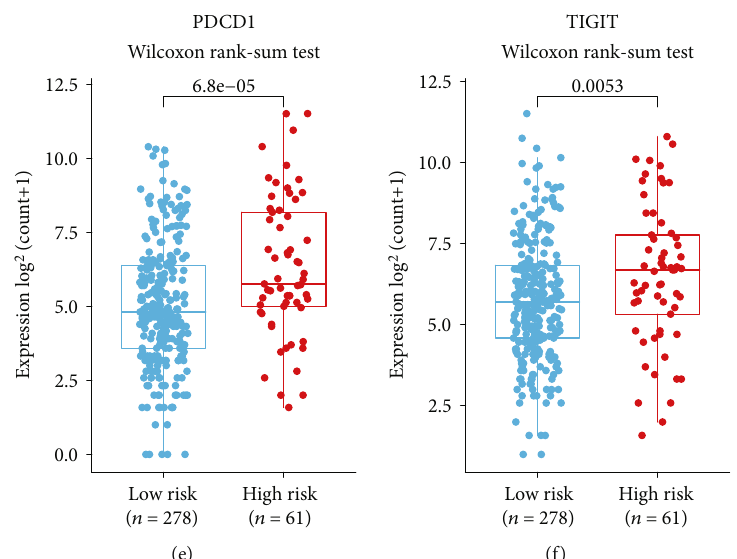
Figure 11: Immunotherapy response analysis. (a) Correlations between immune-related pathways and RS; Kruskal-Wallis test, ∗∗∗ P < 0 : 001 . (b – f) Correlations between several prominent immune checkpoints and RS: CTLA4 (b), HAVCR2 (c), LAG3 (d), PDCD1 (e), and TIGIT (f); Wilcoxon rank-sum test, P values